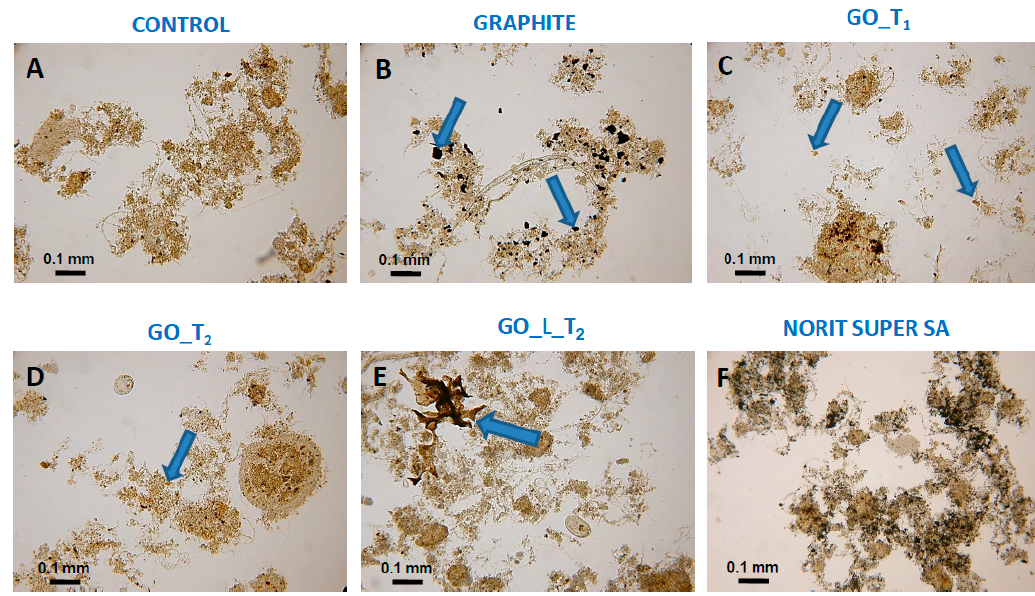
Figure 5. Optical microscope view of activated sludge for samples containing selected carbon materials (dose 0.5 g/L) after reaction (time = 24 h). The arrows show the particles of the dosed carbon nanoparticles. ( A )—Activated sludge (AC); ( B )—AC with graphite; ( C )—AC with graphene oxide GO_T 1 ; ( D )—AC with graphene oxide GO_T 2 ; ( E )—AC with graphene oxide after lyophilization;